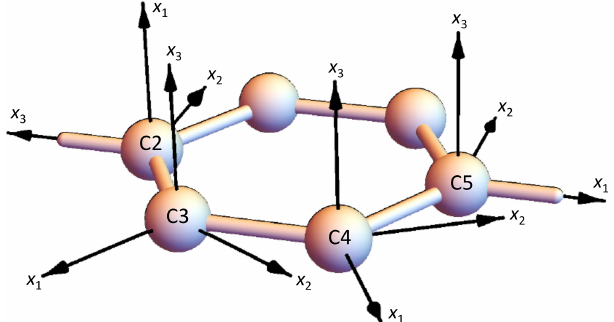
Figure 6. Orientation of the 13 C CST PAFs in the benzene ring (C3,4 are C–H and C2,5 are the para-substituted C q ). The orienta- tion of the C5 PAF corresponds to the convention mentioned above; for the alternative orientation, x 1 axis and x 3 axis had to be ex-